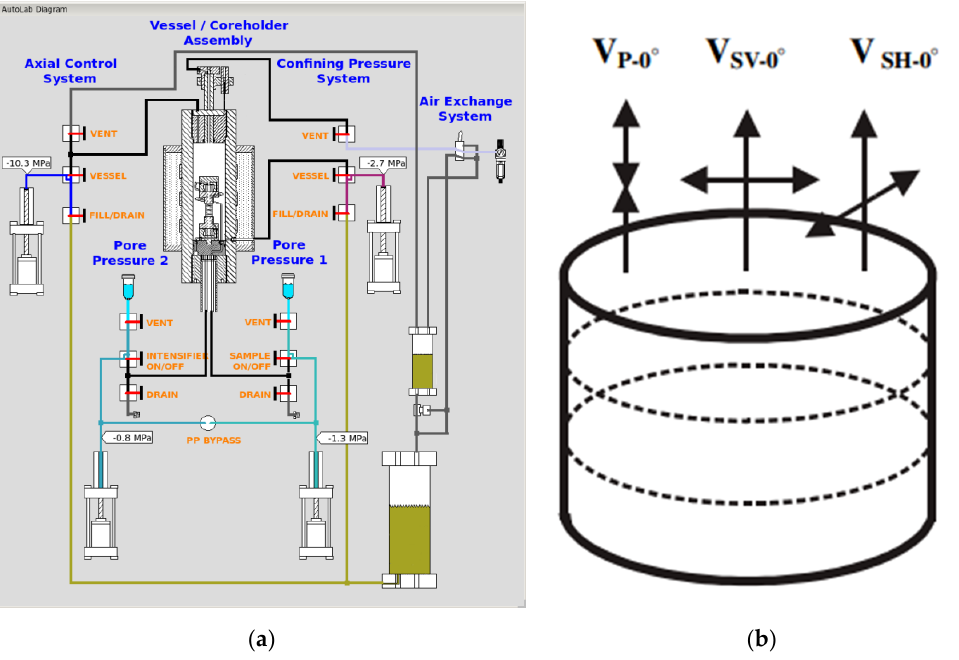
Figure 2. ( a ) AutoLab system and ( b ) scheme of preparation and P- and S-wave velocity measure- ments in samples [14].